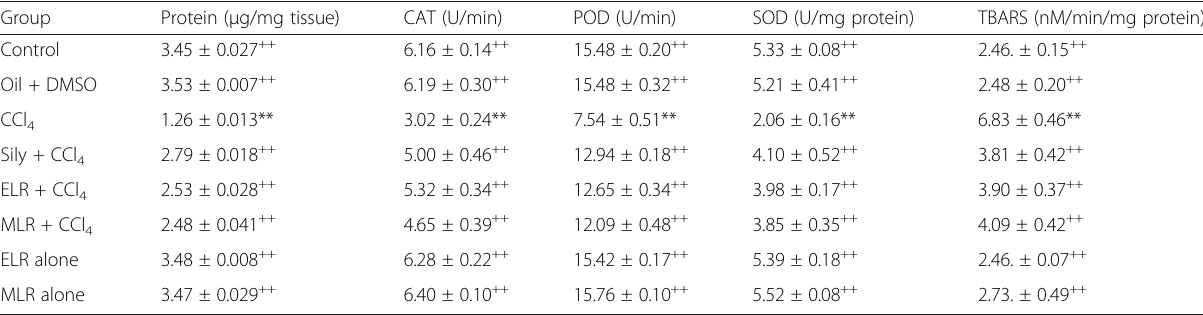
Table 3 Effects of various fractions of R. hastatus leaves on tissue proteins and antioxidant enzyme